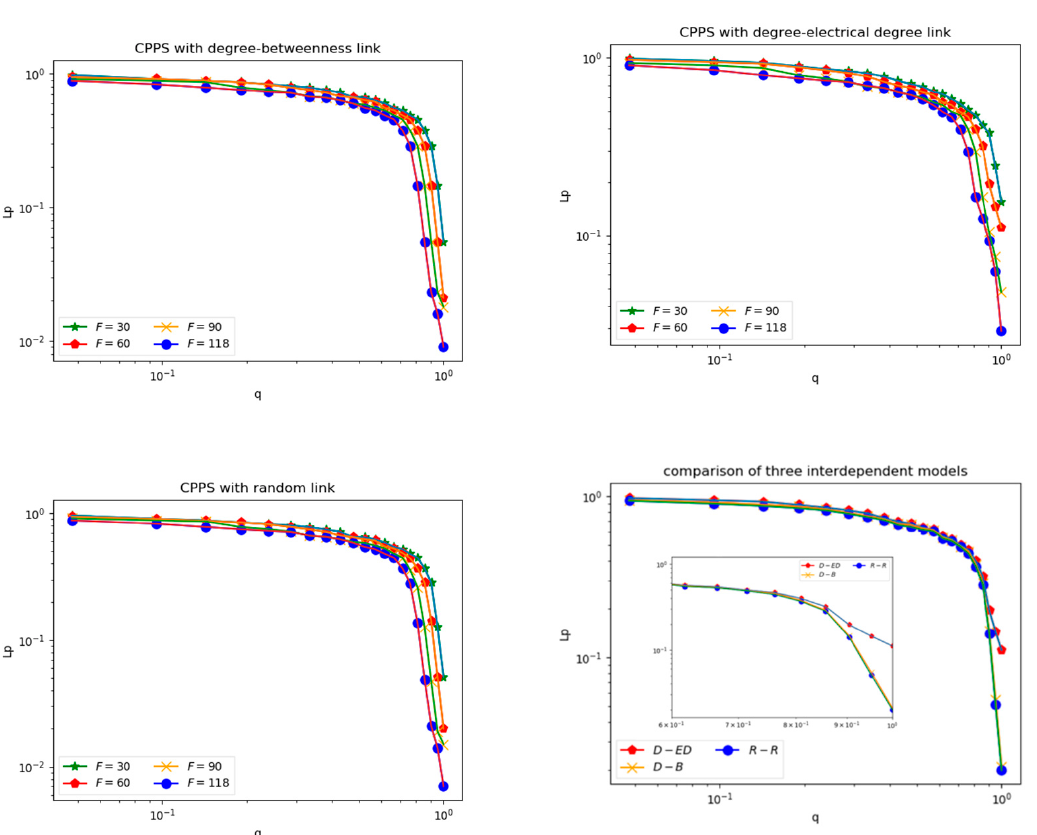
Figure 8. The vulnerability of cyber-physical power systems (CPPS) under random attacks.